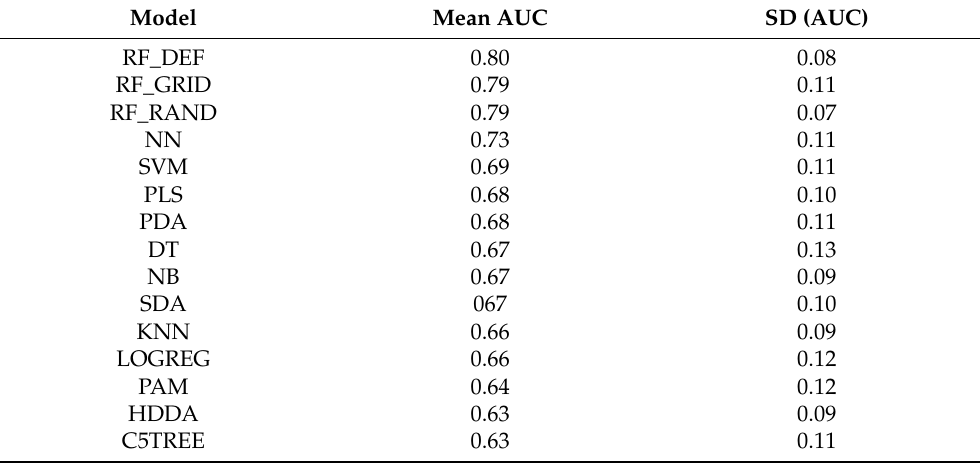
Table 5. Mean and standard deviation (SD) values obtained in terms of area under the receiver operating characteristic curve (AUC) on the 24 iterations performed for model selection.